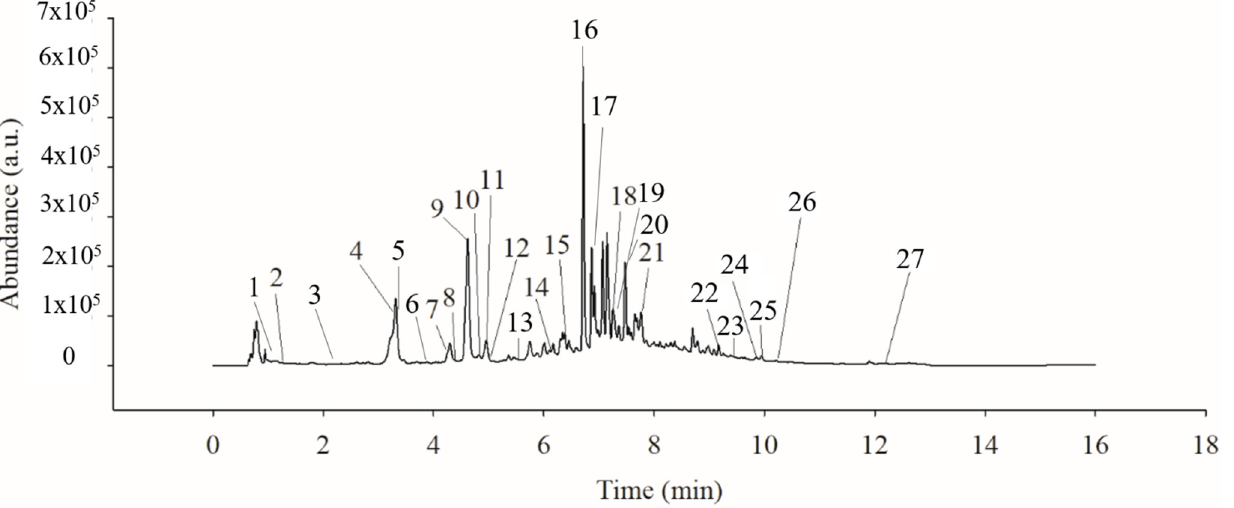
Figure 1. Polyphenols compounds associated with dietary fiber of Quince fruit ( Cydonia oblonga Mill.).